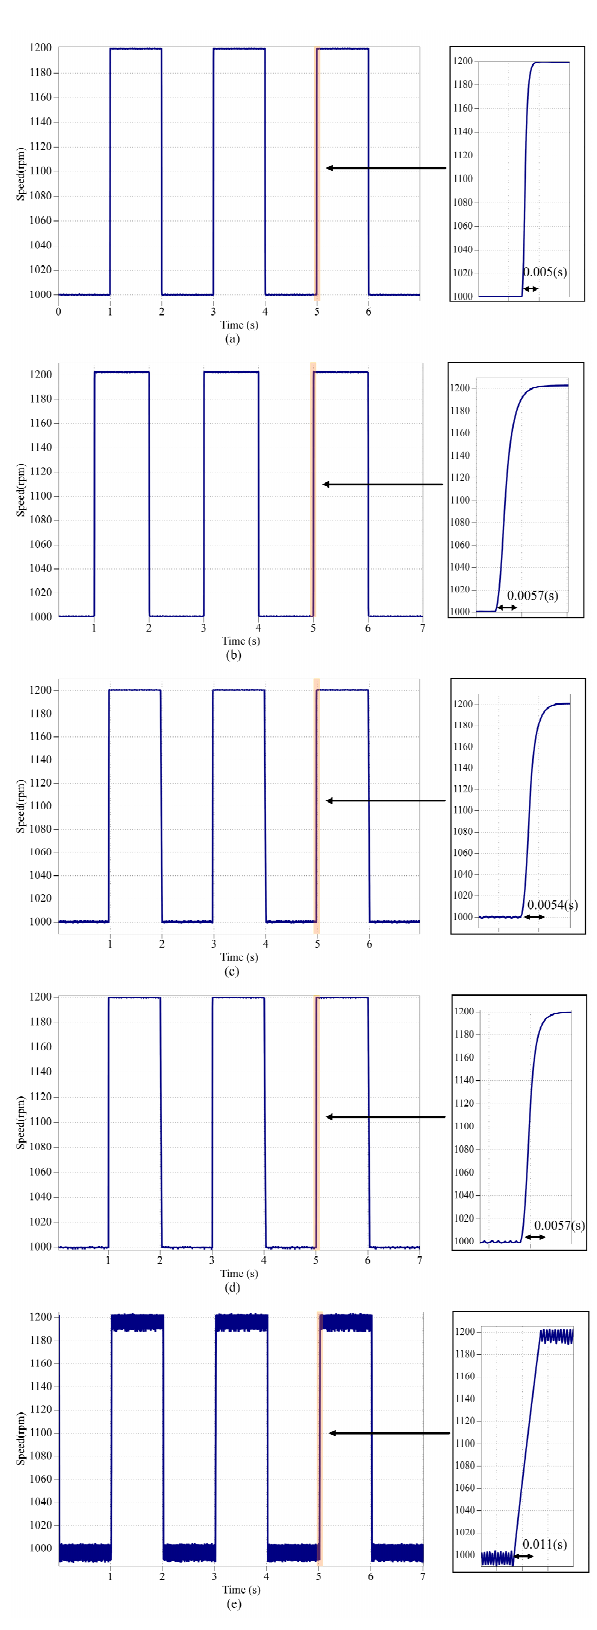
Figure 9. Experimental dynamic speed response of the PMSM under the no ‐ load condition and two ‐ step reference speed using HIL. ( a ) OLS ‐ FOSMC, ( b ) PR ‐ FOSMC, ( c ) RF ‐ FOSMC, ( d ) SVM ‐ FOSMC, ( e ) SMC.